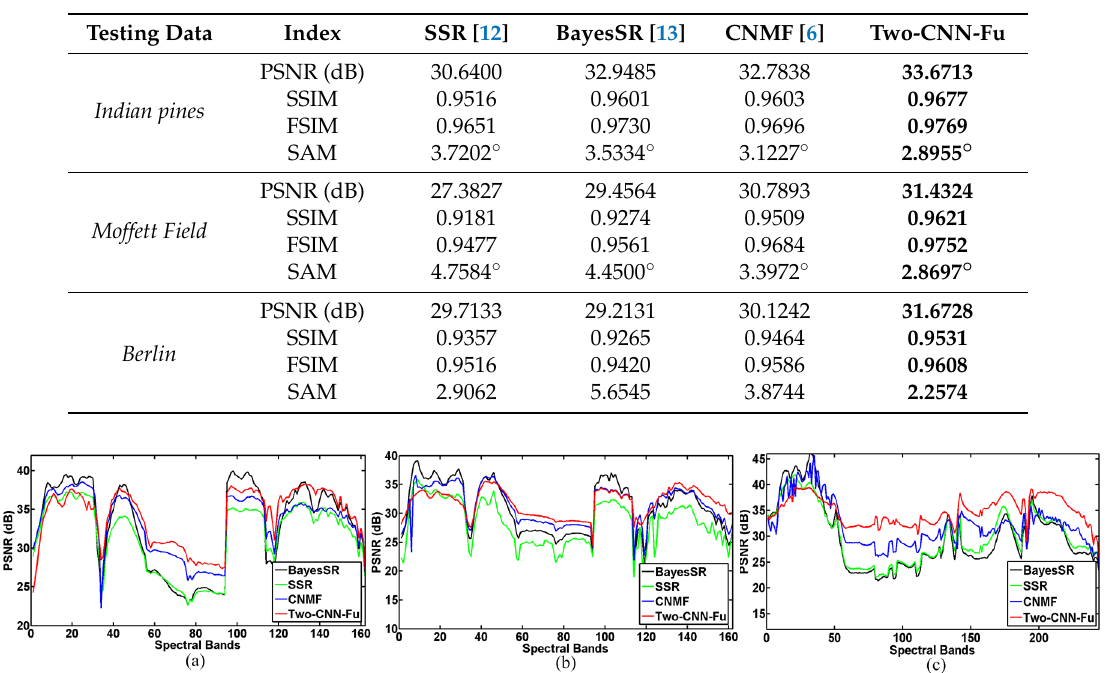
Figure 5. PSNR values of each band of different fusion results by a factor of two, ( a ) on AVIRIS Indian pines data; ( b ) on AVIRIS Moffett Field data; ( c ) on EnMAP Berlin